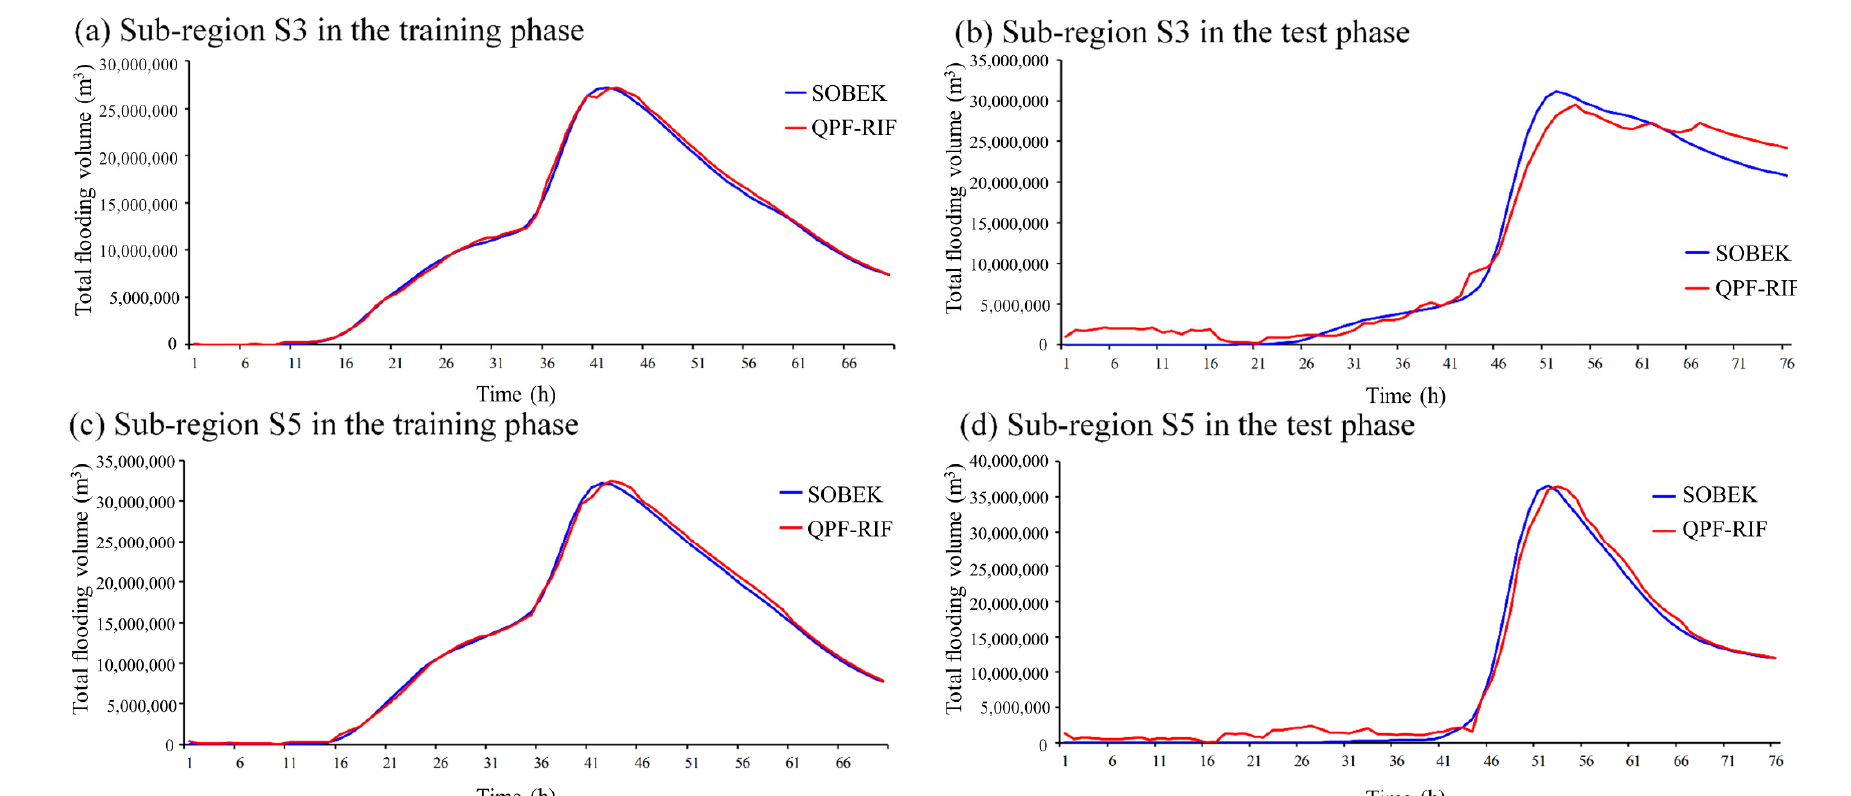
Figure 7. Comparison of the total flooding volume for 1 h lead-time forecasts of the SOBEK and SVM-MSF for S3 and S5 in the training and testing phases.